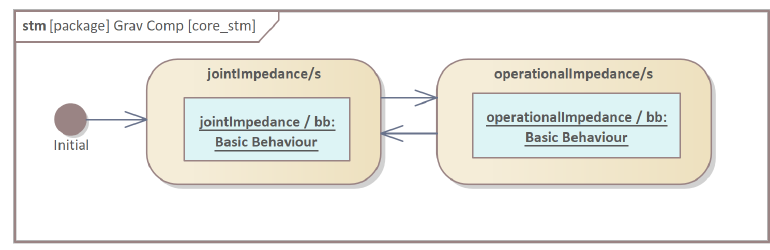
Figure 5. Finite state machine core/a.cs.fsm.